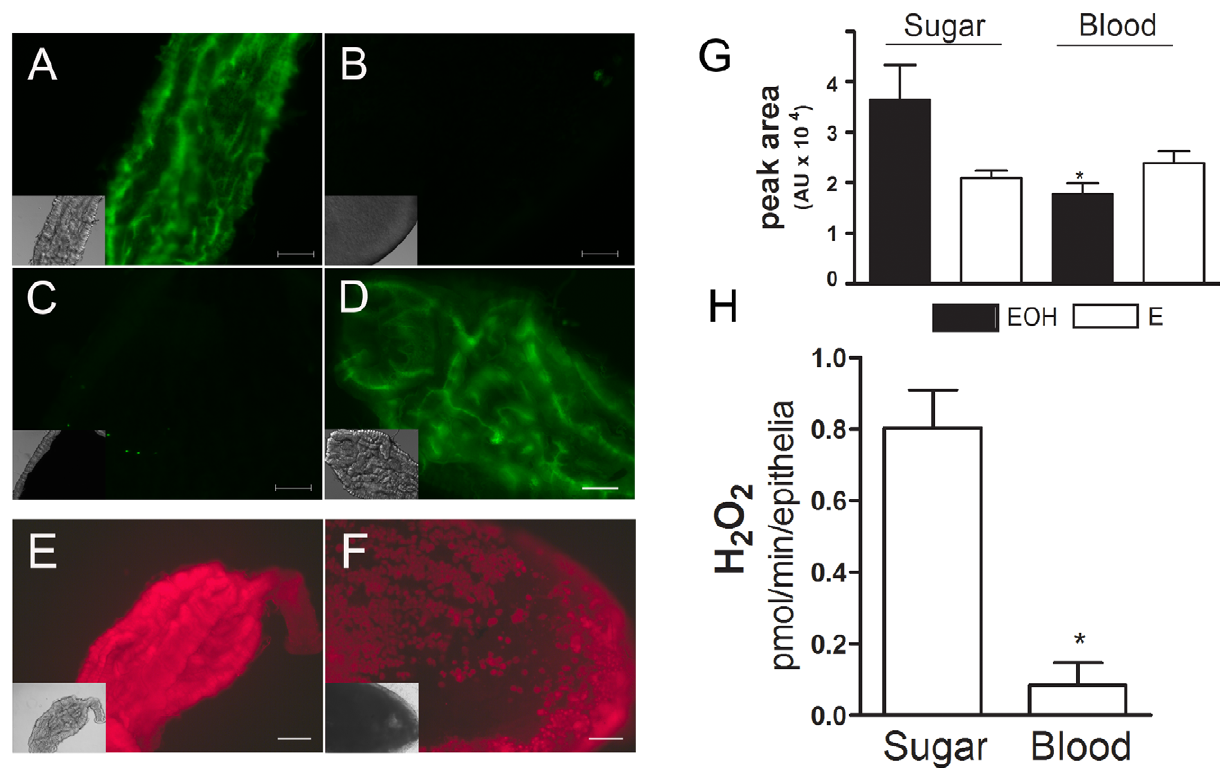
Figure 1. Blood meal decreases ROS levels in the midgut. Female mosquitoes were fed with sugar or blood, and midguts were dissected at different times after the meal and incubated with CM-H 2 DCFDA (2 m M) (A–D) or DHE (2 m M) (E–F) for 20 min: (A) sugar; (B) blood (0 hrs after blood ingestion); (C) blood (48 h – before excretion); (D) blood (48 h – after excretion). (E) sugar; (F) blood (24 h). The same camera exposure time was used to allow side-by-side comparison of fluorescence intensity. Differential interference contrast (DIC) images are shown as insets. Scale bar – 100 m m. (G) Superoxide radical production measured by HPLC-separation of DHE oxidation products in midgut epithelia from sugar or blood-fed mosquitoes (24 h). Asterisk indicates P =0.0239 for the comparison sugar-EOH vs blood-EOH ( T -test). EOH – 2-hydroxyethidium; E - Ethidium. (H) Hydrogen peroxide release from midgut. Asterisk indicates statistically different values ( P , 0.05, T -test) between sugar (n=9) and blood-fed (n=6) pools.